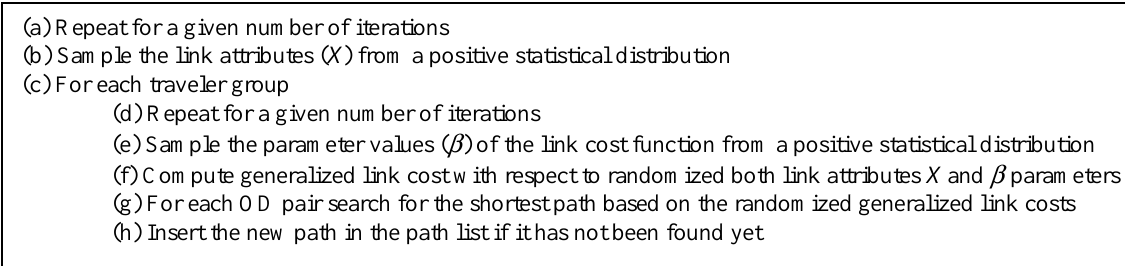
SCHEME 1. Choice set generation algorithm with stochasticity incorporated at attribute and traveler’s preferences